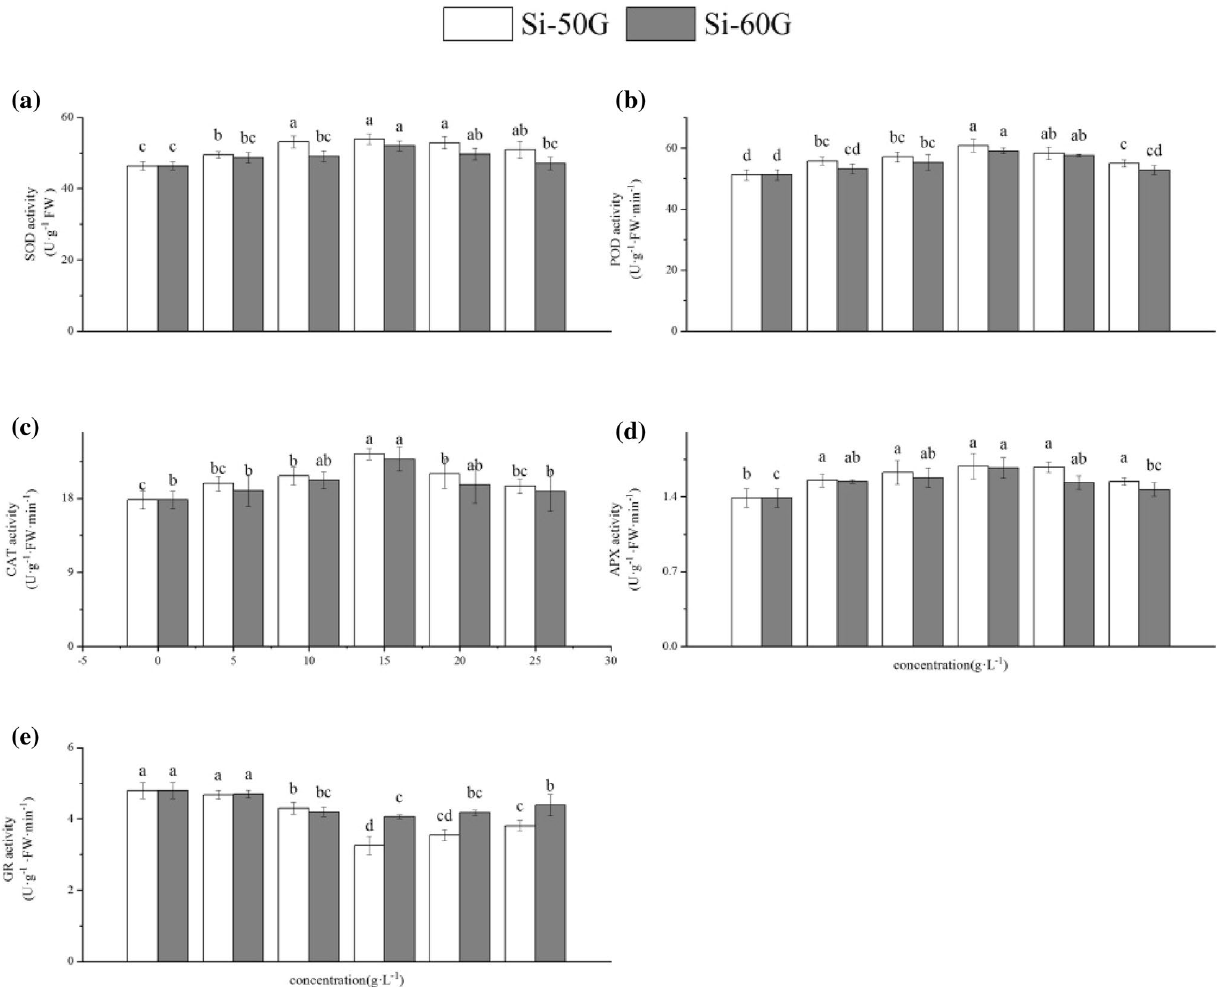
Figure 2. Effects of Si (5, 10, 15, 20, and 25 g·L −1 ) on antioxidant enzyme activities. The values represent the mean ± SE (n = 4). Mean values provided with error bars representing the standard error. Different letters denote statistical differences at P < 0.05.